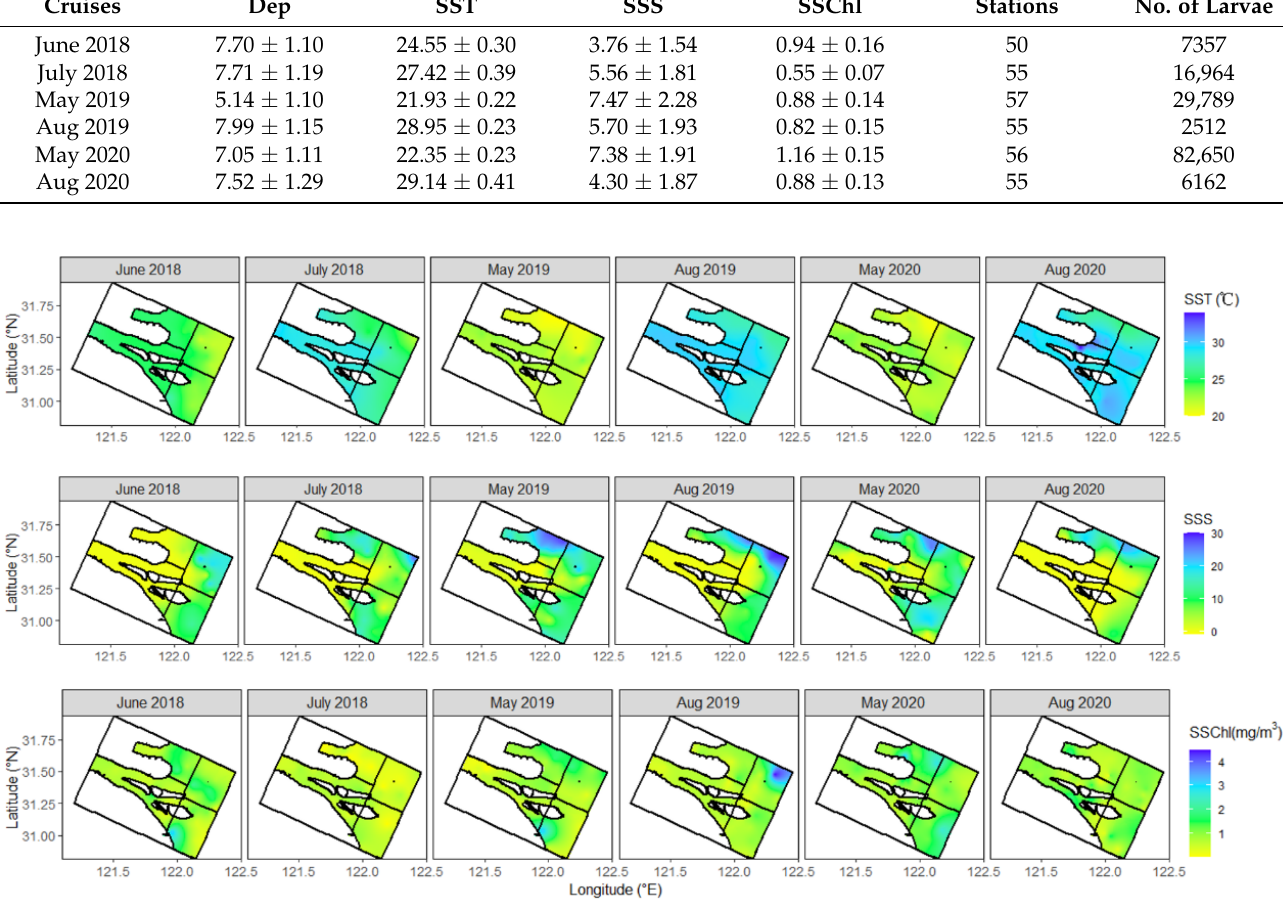
Figure 5. Mean abundance (log (ind./100 m 3 )) of larval fish of different ecological guilds and the Yangtze River flows (100 million m 3 ) from May to August during 2018, 2019, and 2020 (bar plot for abundance of larval fish; line plot for Yangtze River flows).